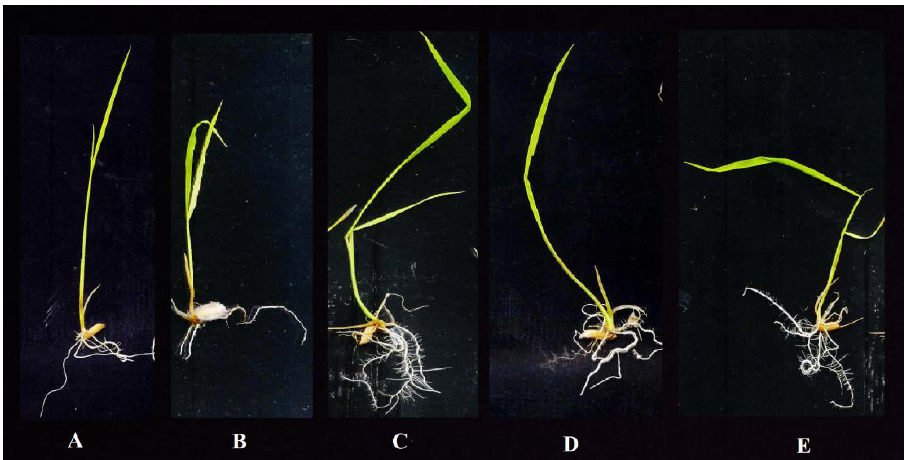
Figure 7. Longitudinal root growth of rice plants after being inoculated with antagonistic Actino- mycetes including ( C ) isolate G, ( D ) isolate U, ( E ) isolate No. 5, ( A ) control, and ( B ) Rhizoctonia solani .